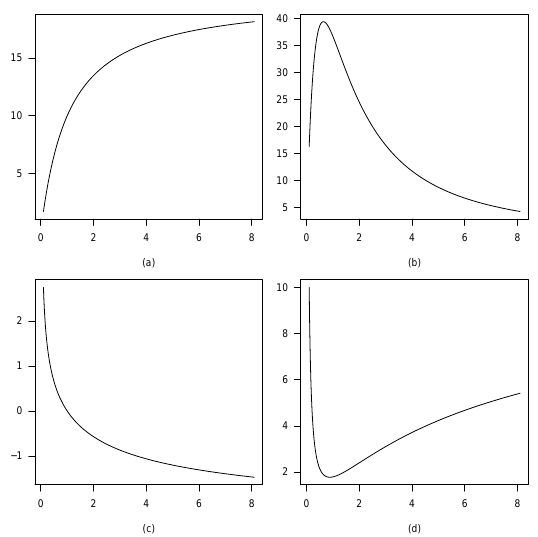
Figure 2 – Mean, in panel (a), variance, in panel (b), skewness, in panel (c), kurtosis, in panel (d), ( α ) } , for m − 1 = 20 and α > of the power uniform distributions { r i